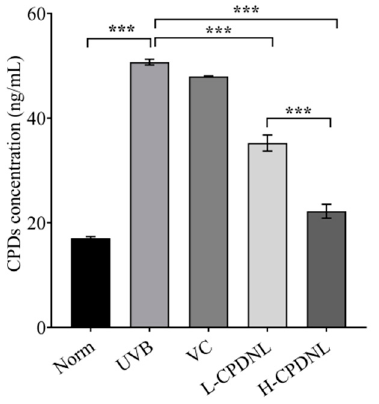
Figure 5. The accumulation of cyclobutane pyrimidine dimers (CPDs, ng/mL). Data represent means ± SEM. *** indicates p < 0.001.